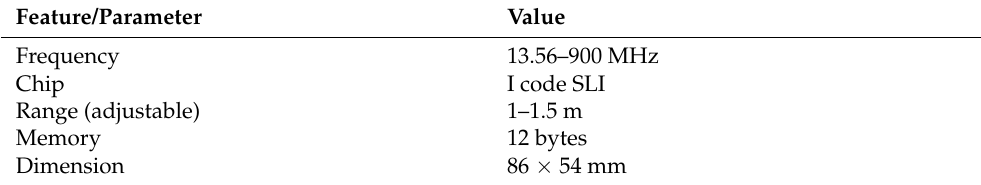
Table 8. Main features of the passive tag.